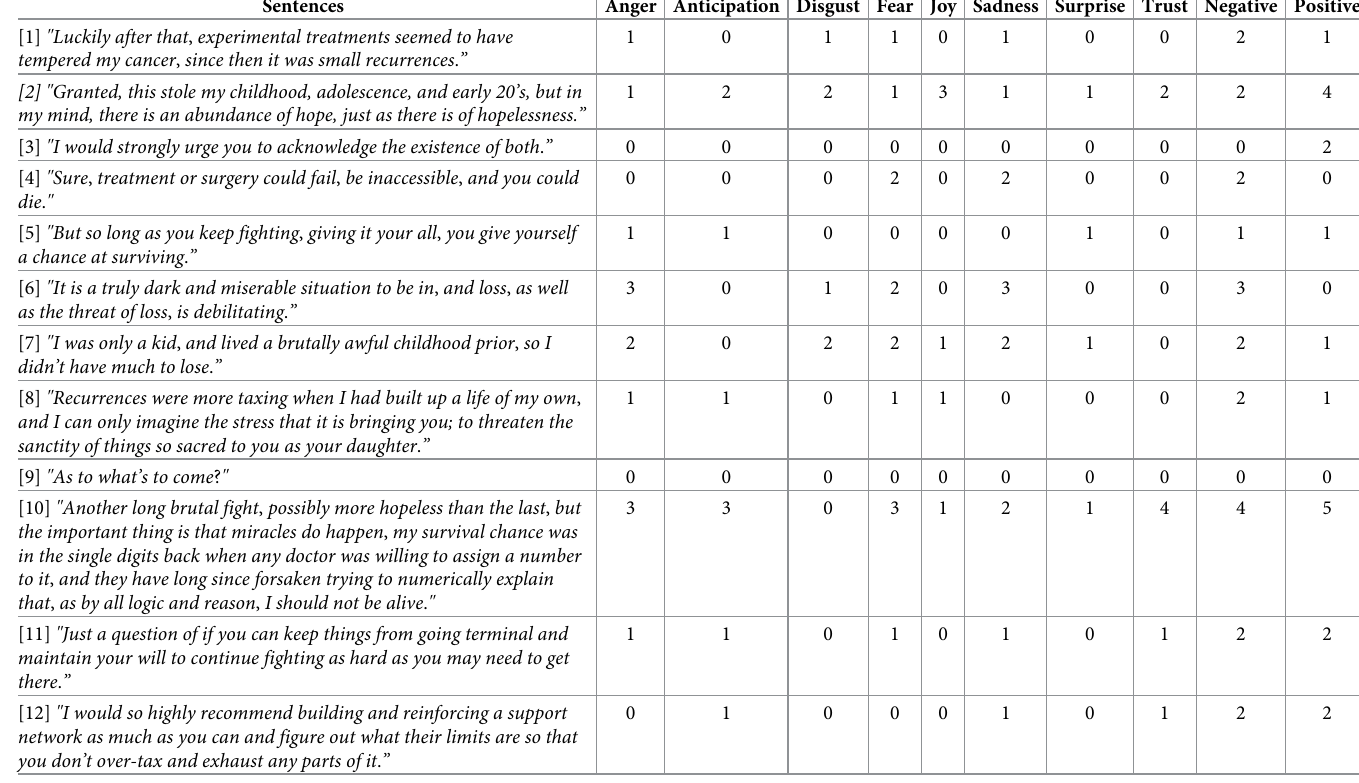
Table 3. Twelve extracted sentences from post ID 59 (user type–type of comment: Patient–experience) along with the sentiments and emotions frequencies for each sentence.